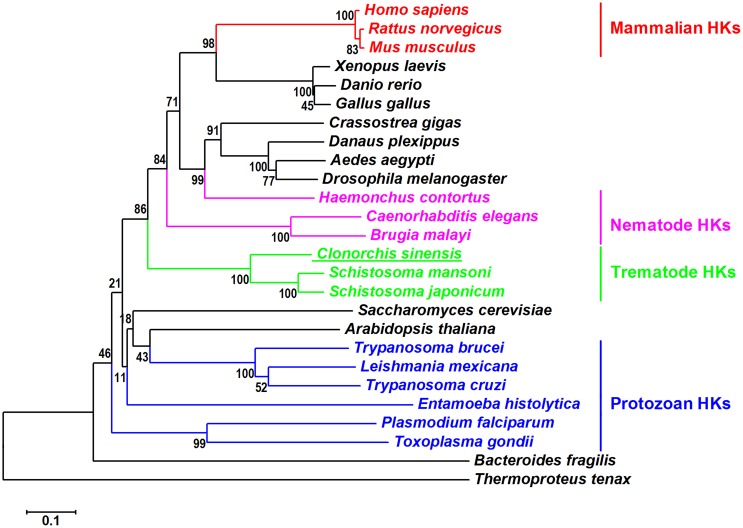
Neighbor-joining phylogenetic tree of HKs.The bootstrap values are shown at the branching point (1,000 replications). The amino acid sequences were retrieved from DDBJ and GenBank. The sequences are as follows: Homo sapiens (NP_000153.1, glucokinase isoform 1), Rattus norvegicus (P17712.2, Glucokinase), Mus musculus (NP_034422.2, glucokinase), Xenopus laevis (AAH72832.1, Hk1-A protein), Danio rerio (AAH67330.1, Hexokinase 1), Gallus gallus (BAC20932.1, hexokinase1), Crassostrea gigas (EKC42666.1, Hexokinase type 2), Danaus plexippus (EHJ75730.1, hexokinase), Aedes aegypti (EAT38749.1, hexokinase), Drosophila melanogaster (AGB95227.1, hexokinase A, isoform C), Haemonchus contortus (CAB40412.1, hexokinase), Caenorhabditis elegans (NP_492905.1, Protein H25P06.1), Brugia malayi (AAR13363.1, hexokinase), Clonorchis sinensis (GAA52956.1, hexokinase), Schistosoma mansoni (XP_002575647.1, hexokinase), Schistosoma japonicum (CAX74187.1, Hexokinase A), Saccharomyces cerevisiae (AAA34699.1, hexokinase (HXK2)), Arabidopsis thaliana (Q42525.2, hexokinase-I), Trypanosoma brucei (CAC69958.1, hexokinase), Leishmania mexicana (XP_003875265.1, putative hexokinase), Trypanosoma cruzi (AAL93565.1, hexokinase), Entamoeba histolytica (CAA57682.1, hexokinase), Plasmodium falciparum (AAA29613.1, hexokinase type IV), Toxoplasma gondii (BAB55664.1, hexokinase), Bacteroides fragilis (AAT74901.1, general specificity hexokinase), and Thermoproteus tenax (CAD52839.1, hexokinase).